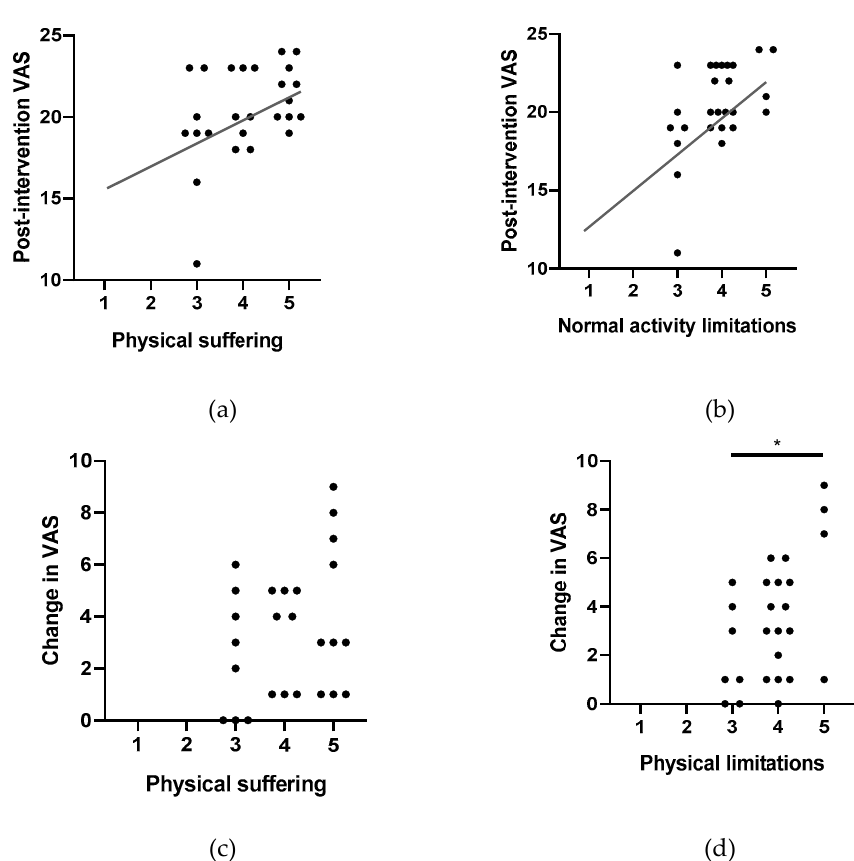
Figure 5. Post-intervention VAS and positive pre- to post-intervention VAS changes are influenced by ( a , c ) physical suffering and ( b , d ) physical activity limitations. ( a ) Post-intervention VAS is predicted by physical suffering (r 2 = 0.405, p = 0.04) and ( b ) physical limitations (r 2 = 0.518, p = 0.007). ( c ) While the student’s perception of physical suffering did not predict the amount of VAS change ( p = 0.3089), ( d ) the student’s perception of normal activity limitations is significantly predicted ( p = 0.0206). * p < 0.05.